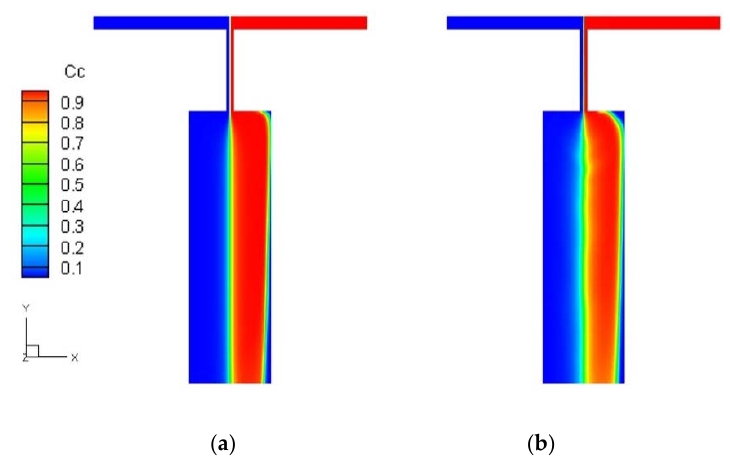
Figure 2. Concentration distribution in the Newtonian fluid case ( a ) and viscoelastic fluid case ( b ) under constant driving pressure at both inlets.